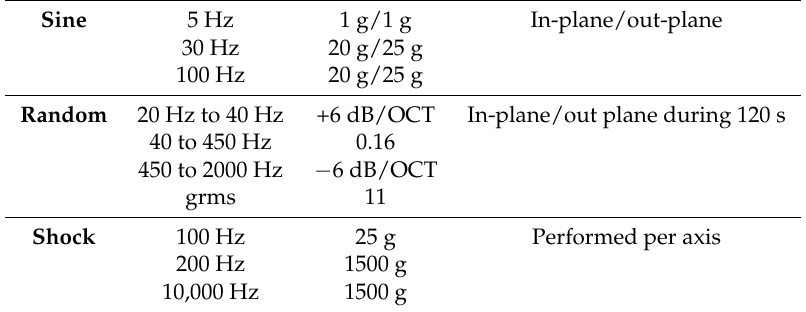
Table 1. Exomars mission vibration requirements for the laser unit. Table reproduced from